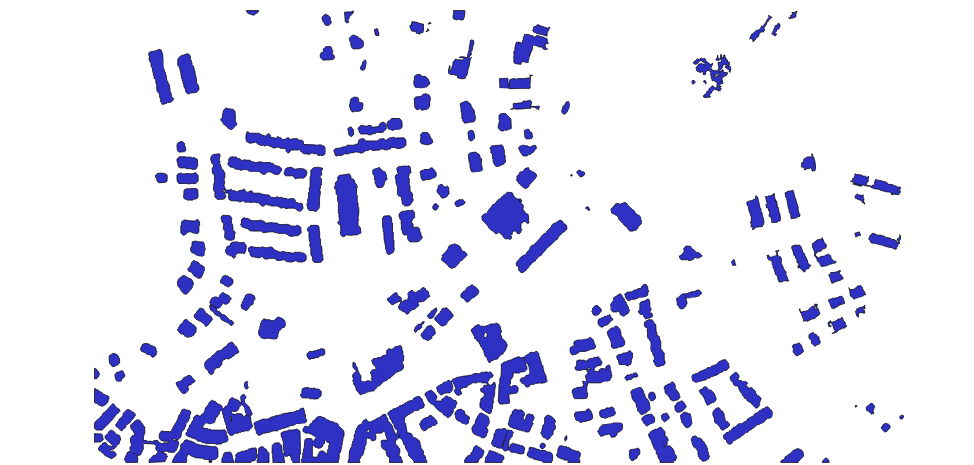
Figure 9. Result of buildings extraction over the selected first area of